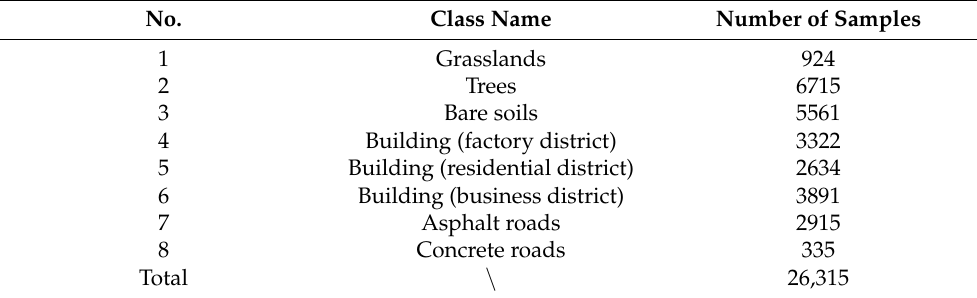
Table 1. Ground truth land cover classes and the corresponding numbers of samples.